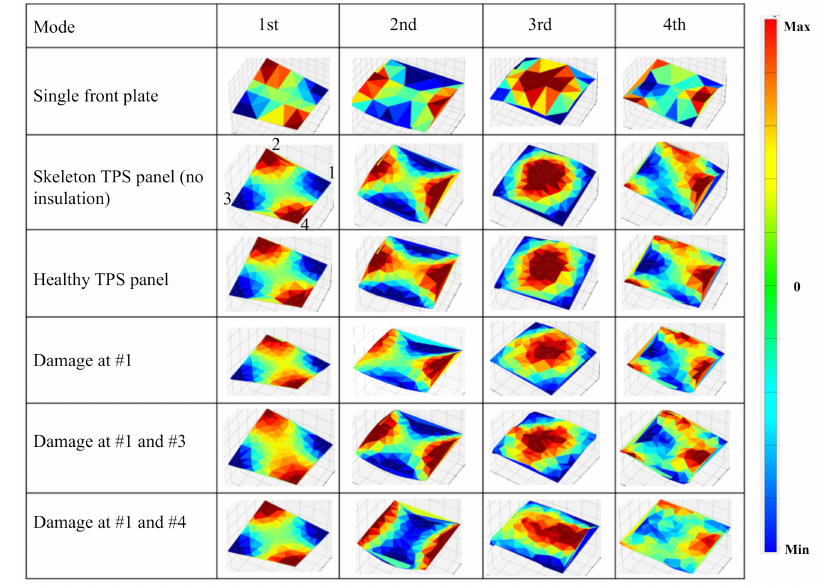
Figure 19. Summary of the operational deflection shapes (ODSs) at the first four natural frequencies: single load-carrying plate, skeleton TPS panel (without fibrous insulation material), healthy assembled TPS panel, damage at specific corners. Note: the order of the corners in all ODSs are the same in the current